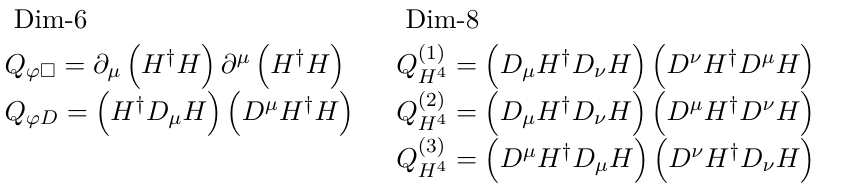
+ 3 C + C = 1 with the positivity cone, and the degeneracy ∆ 1 2 3